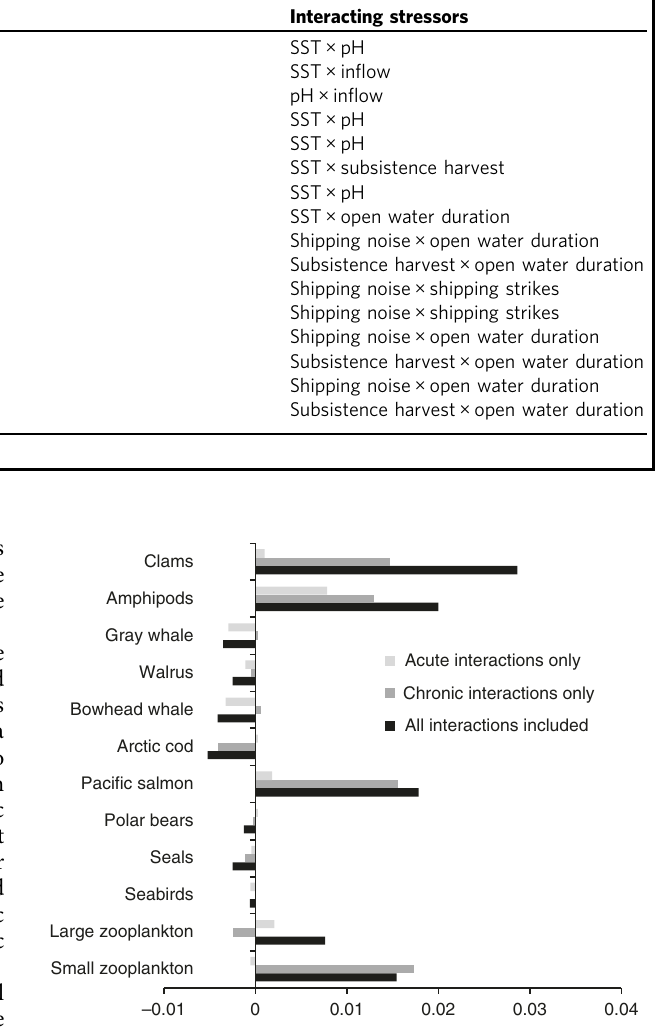
Fig. 2 The sensitivity of the biomass of each node to interaction strength. This was calculated as the slope of the relationship between the mean fi nal biomass of each node and changes in interaction strength, which varied from antagonistic to synergistic. Example data from which the slopes were calculated are shown in Fig. S3. A separate set of simulations was run with only acute stressor interactions included, only chronic stressor interactions included, and all stressor interactions included. Positive numbers indicate that biomass increased with increasing interaction